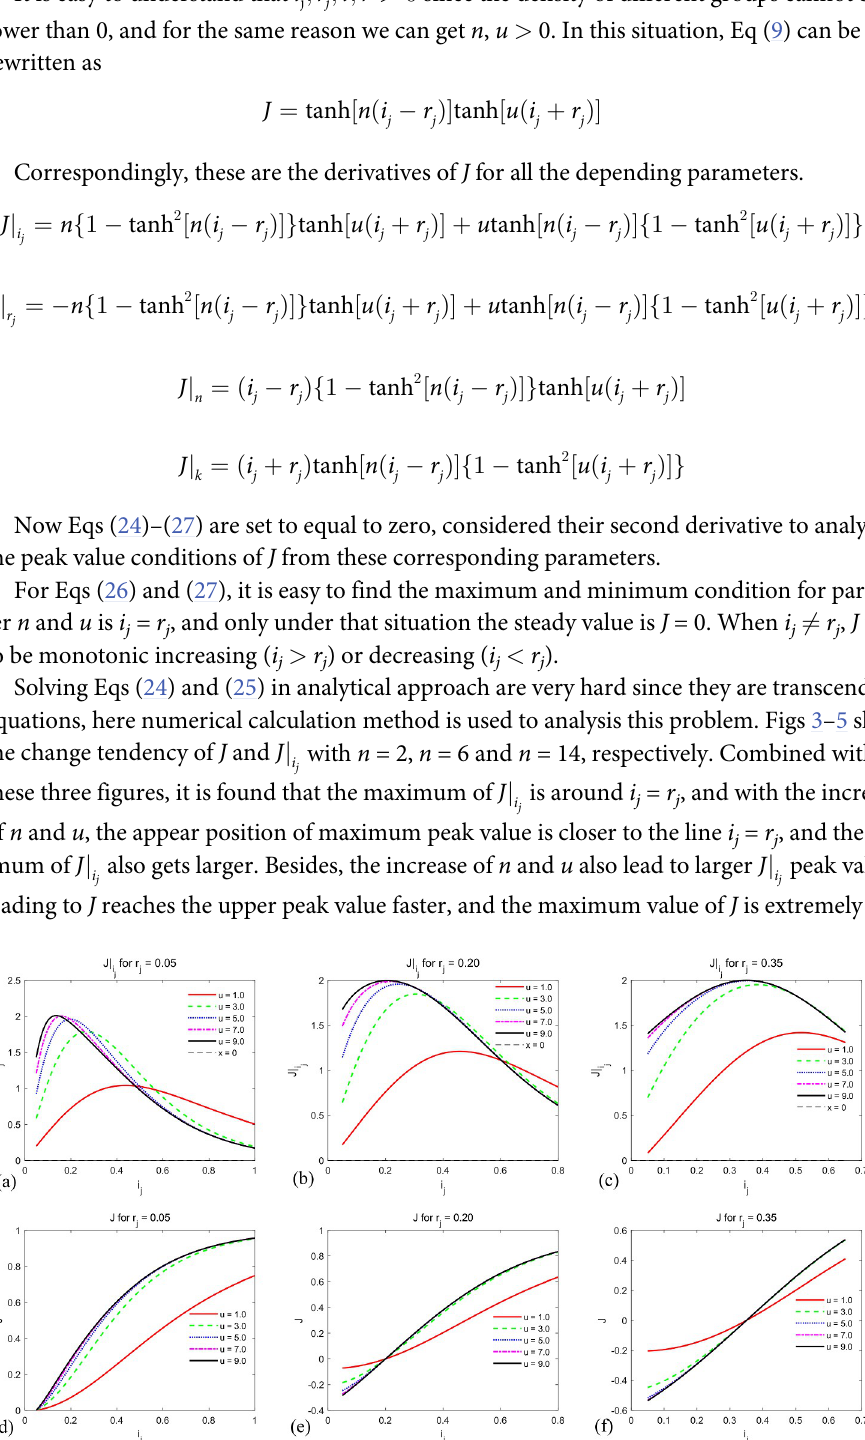
by different i j i j and u with r = 0.05, j j